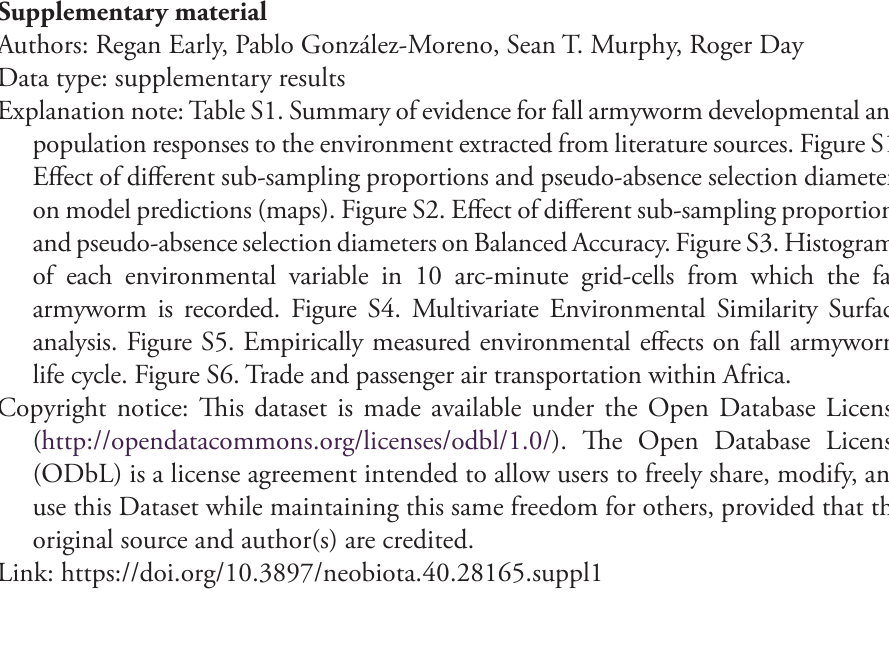
Table S2. Distribution data from the